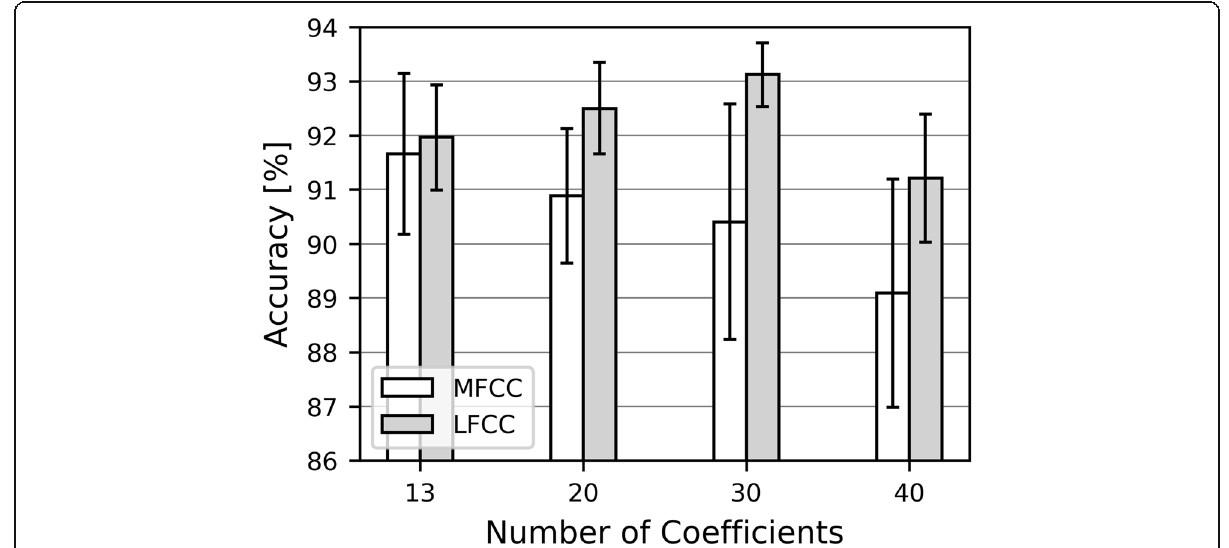
Fig. 6 Mean discrimination accuracy scores obtained using MFCCs and LFCCs (Logit classifier). Error bars denote standard